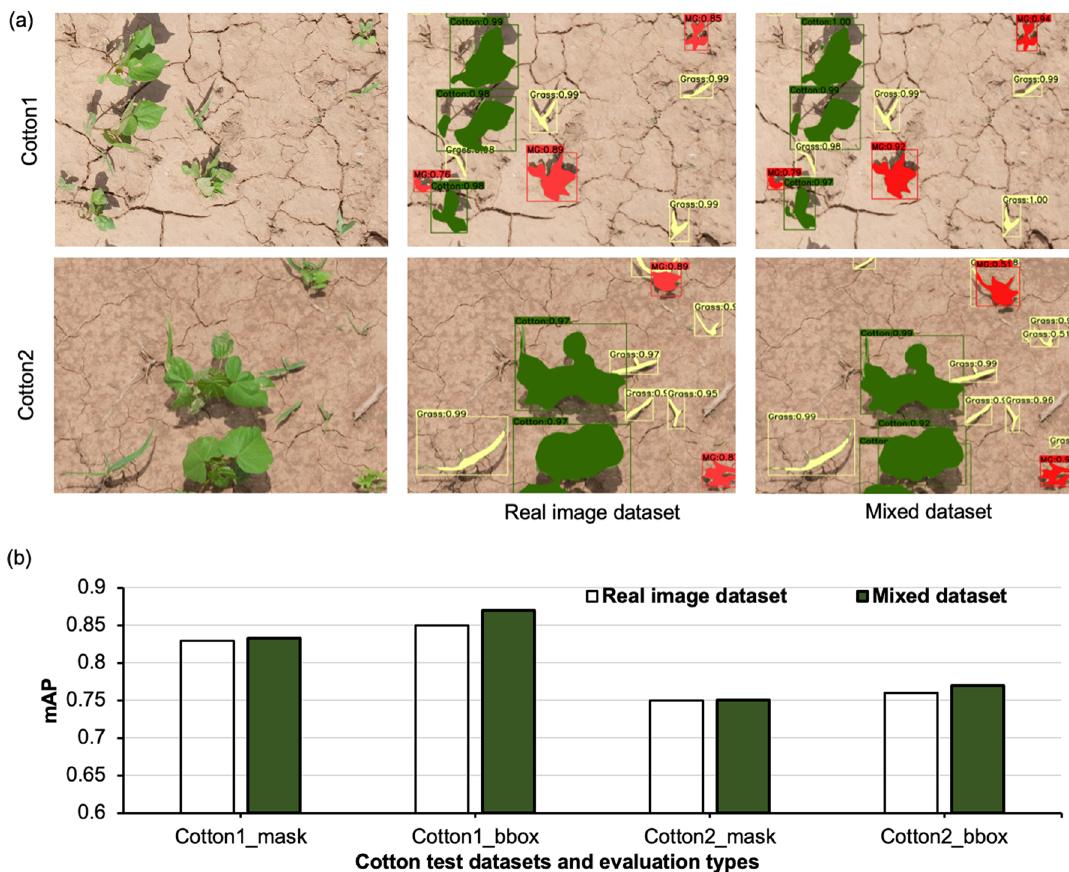
Figure 10. Results obtained from models trained with real image dataset and mixed dataset (original real images + real plant-based synthetic images): ( a ) Detection and segmentation results obtained for the test datasets Cotton1 and Cotton2, and ( b ) Mean average precision (mAP) values for bounding box (bbox) and mask results obtained for Cotton1 and Cotton2. Here, green, red, and yellow detected masks represent cotton, morningglories, and grass,